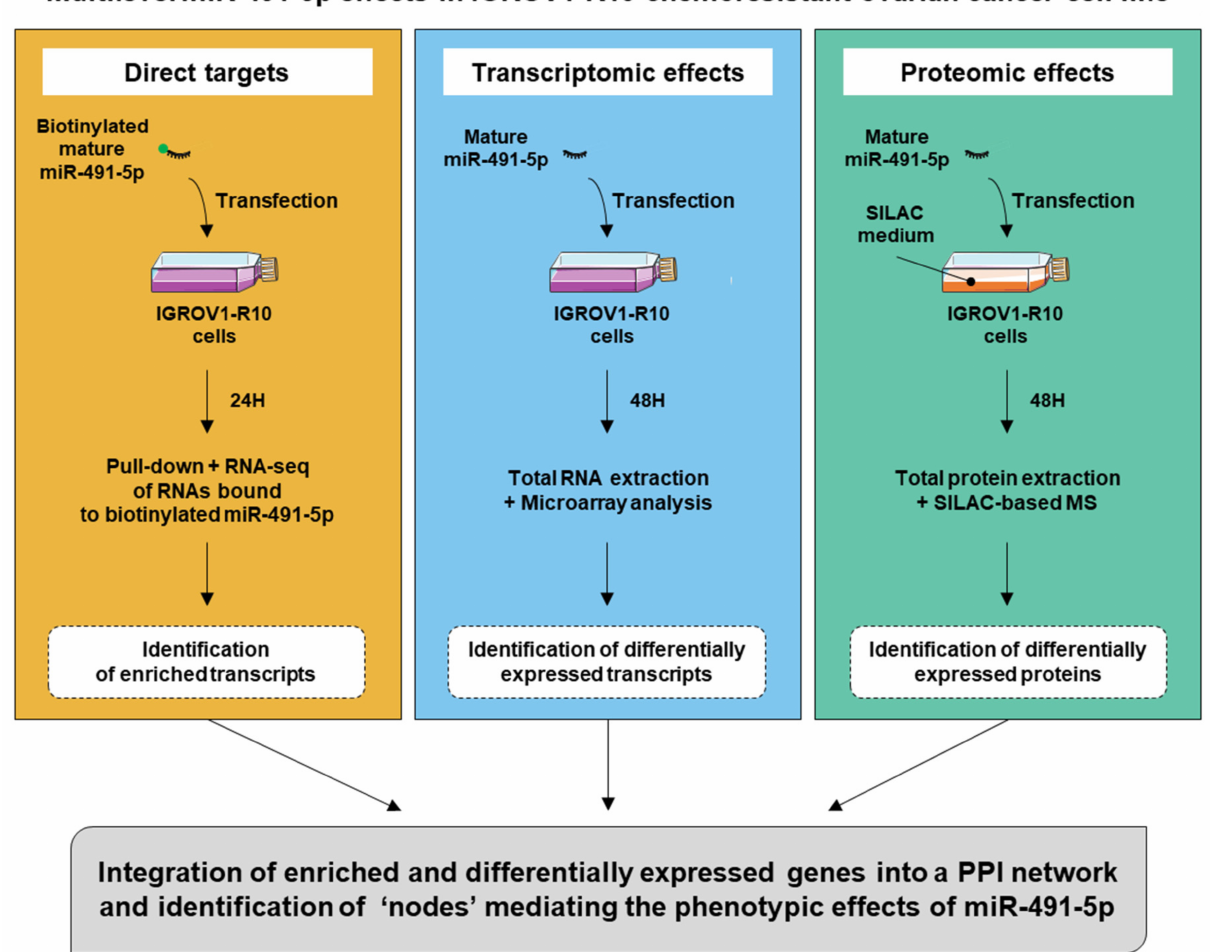
Figure 1. Schematic representation of experiment workflow. RNA sequencing data of the pulled-down experiment were processed as described in Methods, and an enrichment ratio was computed for each transcript. As shown in Figure S1A the pull-down ratio follows a log-normal distribution centered in 0 (1-fold), indicating that the majority of transcripts are not enriched (or depleted) in the pull-down compared to input. The right elbow of this distribution is used as a cut-off (enrichment ratio of 0.95 in log2 scale) for the definition of the set of enriched transcripts. Out of the 2754 selected transcripts (Dataset 1 and Figure S1B), Bcl-xL (BCL2L1) and GIT1 were both present. These two transcripts have been previously shown to be direct targets of miR-491- 5p [9,13], supporting the reliability of our data. However, EGFR, another direct target of miR-491-5p, was not selected (enrichment ratio of 0.4) in our experiment (Dataset 1). Transcriptomic and proteomic data were processed as described in Methods. Setting a fold change cut-off of 0.5 (log2) for both experiments. We selected 739 (620